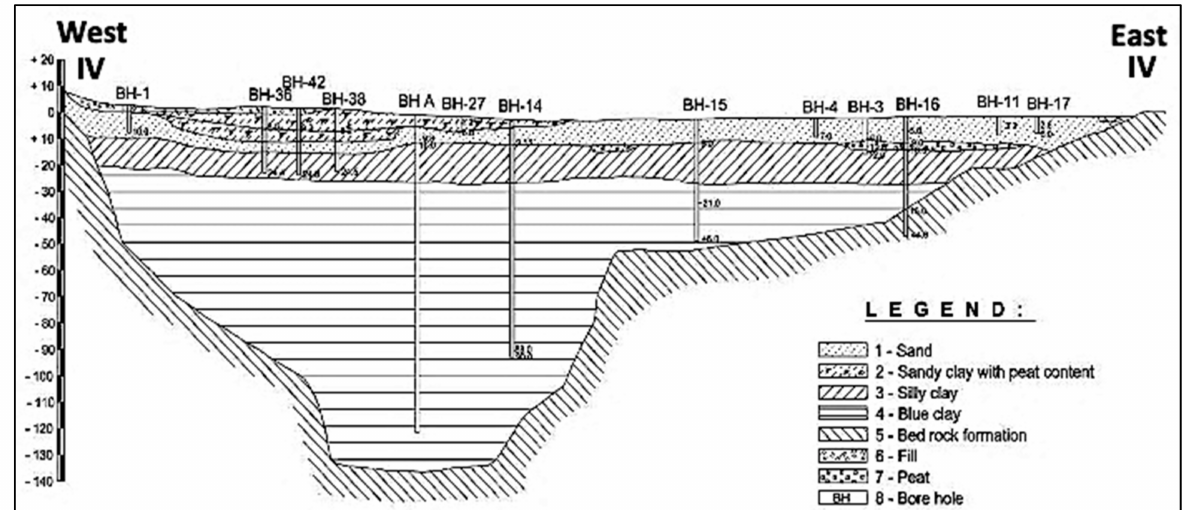
Figure 6. Geologic cross-section IV—IV [30].